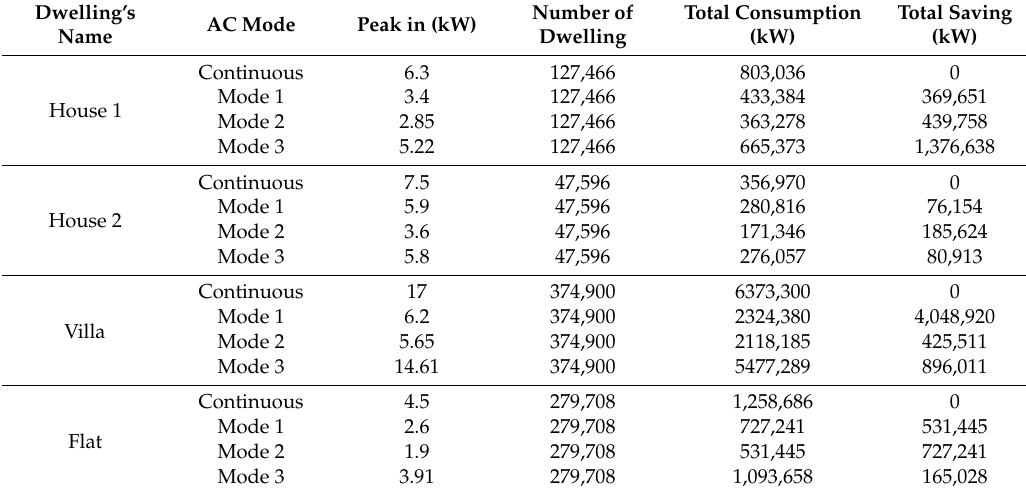
Table 11. The total peak power and savings for each house on different AC operations modes for the whole of Riyadh region.